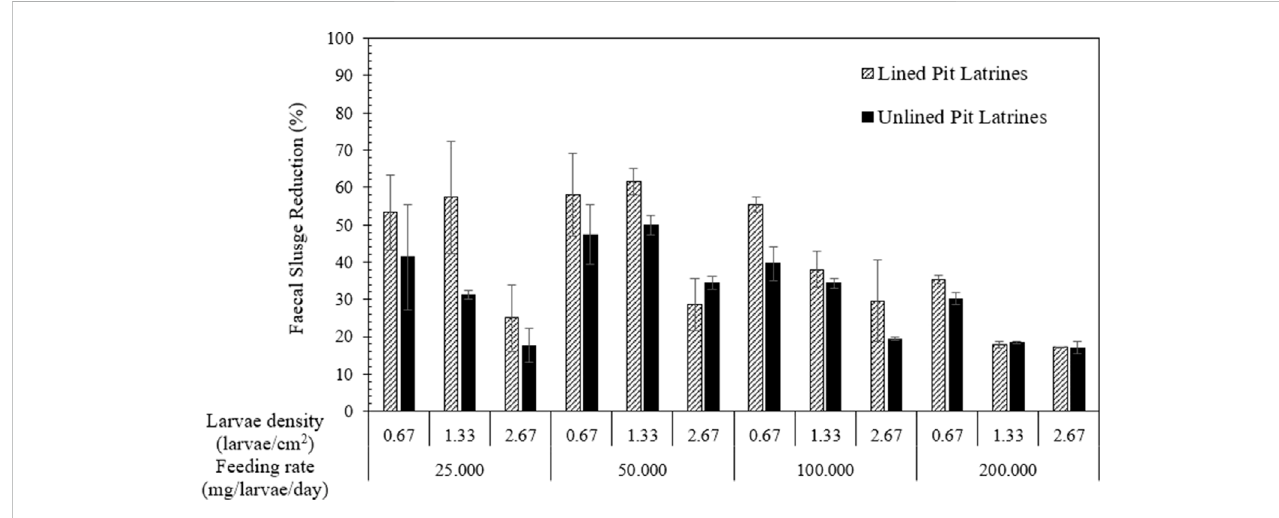
FIGURE 2 Percentage of faecal sludge reduction (FSR) with feeding rate (FR) and larvae density (LD) for FS from lined and unlined pit